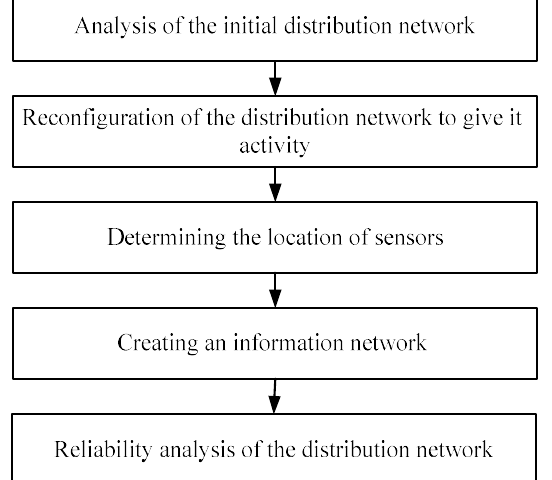
Figure 11. Flowchart of an algorithm for analyzing the reliability of flexible power distribution net- works.